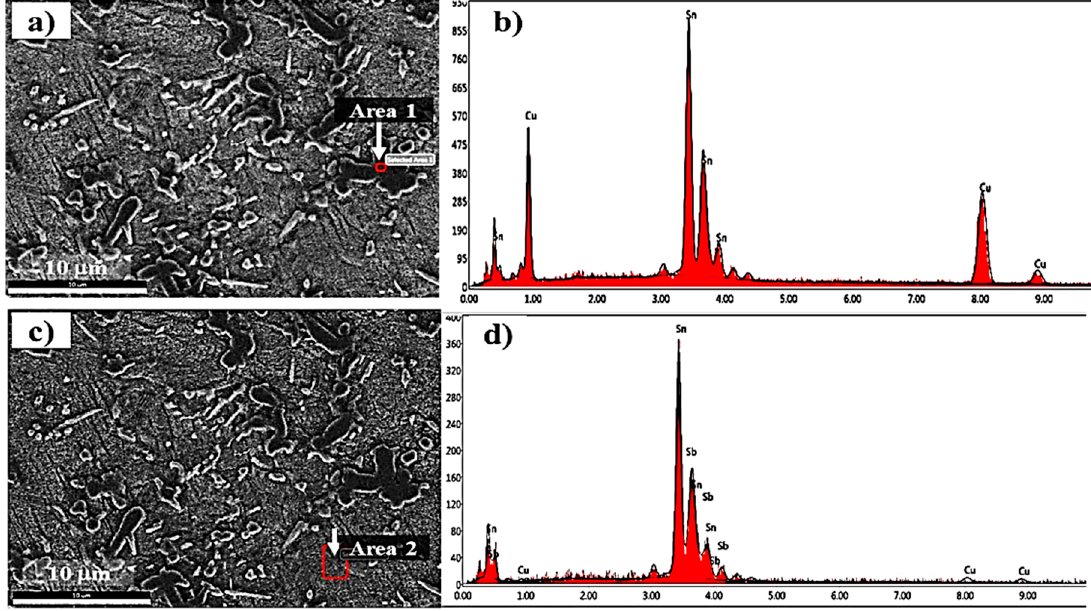
Figure 4. ( a,c ) SEM images of tin-based Babbitt alloy and ( b,d ) graphical presentation of EDS microanalysis of precipitates (Area 1) and matrix (Area 2) in Sn-based Babbitt alloy.